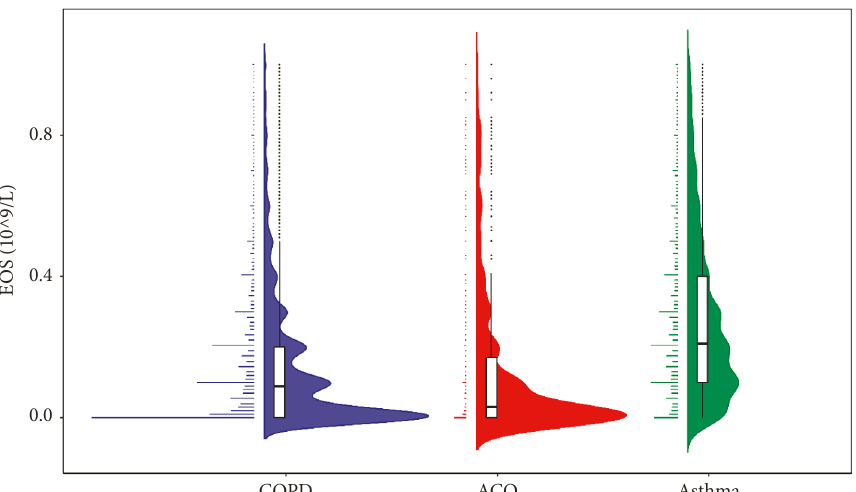
Figure 4: The eosinophil counts in the three study populations. (COPD, chronic obstructive pulmonary disease; ACO, asthma-COPD overlap; EOS, eosinophils).